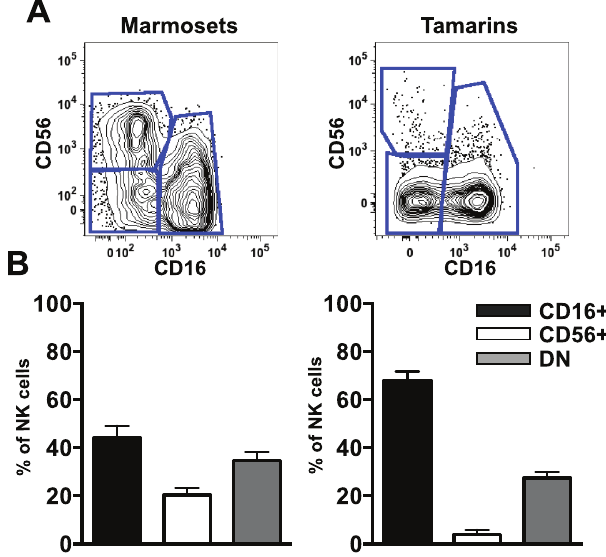
Figure 2. Disparate frequencies of NK cell subpopulations among neotropical primate species. ( A ) Representative flow cytometry plots displaying NK cell subpopulations based on CD56 and CD16 expression gated on NKp46 + NK cells as shown in Figure 1. ( B ) Graphic comparisons of NK cell subpopulations among common marmosets and cotton-top tamarins (lower panels). DN, double- negative.